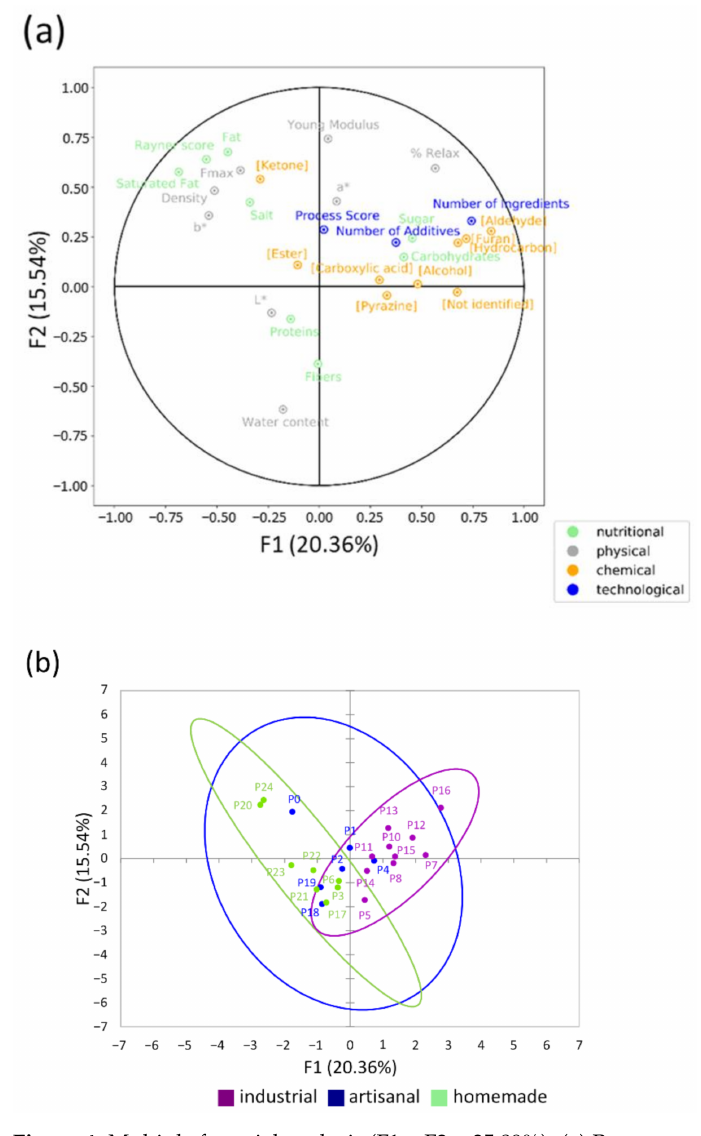
Figure 4. Multiple factorial analysis (F1 + F2 = 35.89%). ( a ) Representation of the correlations among the different variables quantified in each type of analysis (nutritional = rayner, total fat, saturated fat, total carbohydrate, sugar, fibers, proteins, salt; physical = density, F max , percentage of relaxation, Young’s modulus, L*, a*, b*, water content; chemical = 46 volatile molecules (Table 4), represented by their nine chemical families; technological = Process-Score, number of ingredients, number of additives, with the same weight for each of the four groups); ( b ) biplot of the 24 soft breads in this representation, presented according to processing